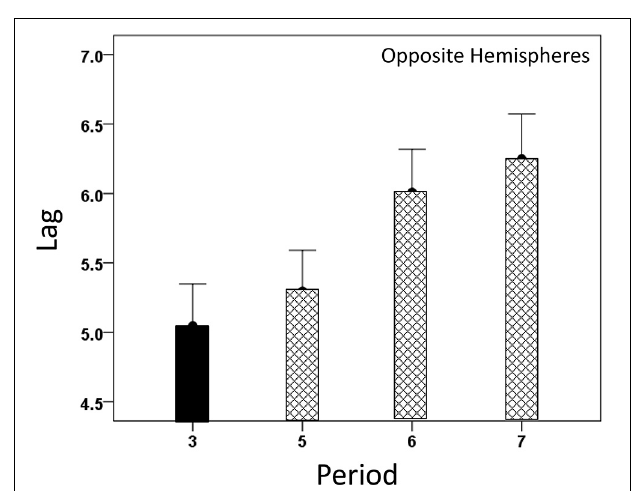
FIGURE 15 | Modulation of opposite-hemisphere CC max lag during task periods, being shortest at period 3 (see text for